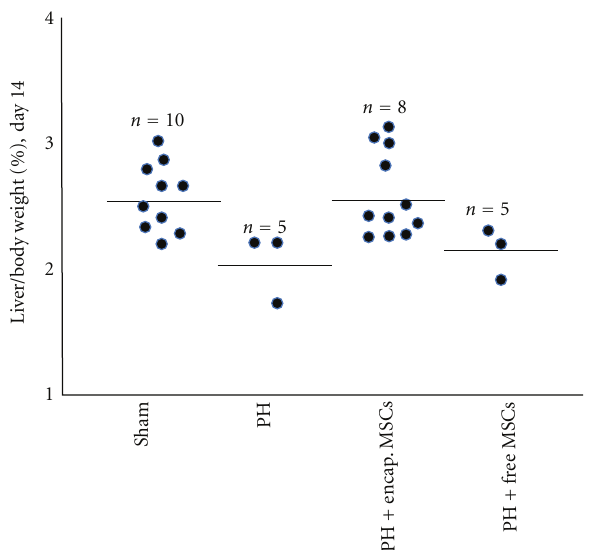
Figure 4: HGF in plasma.